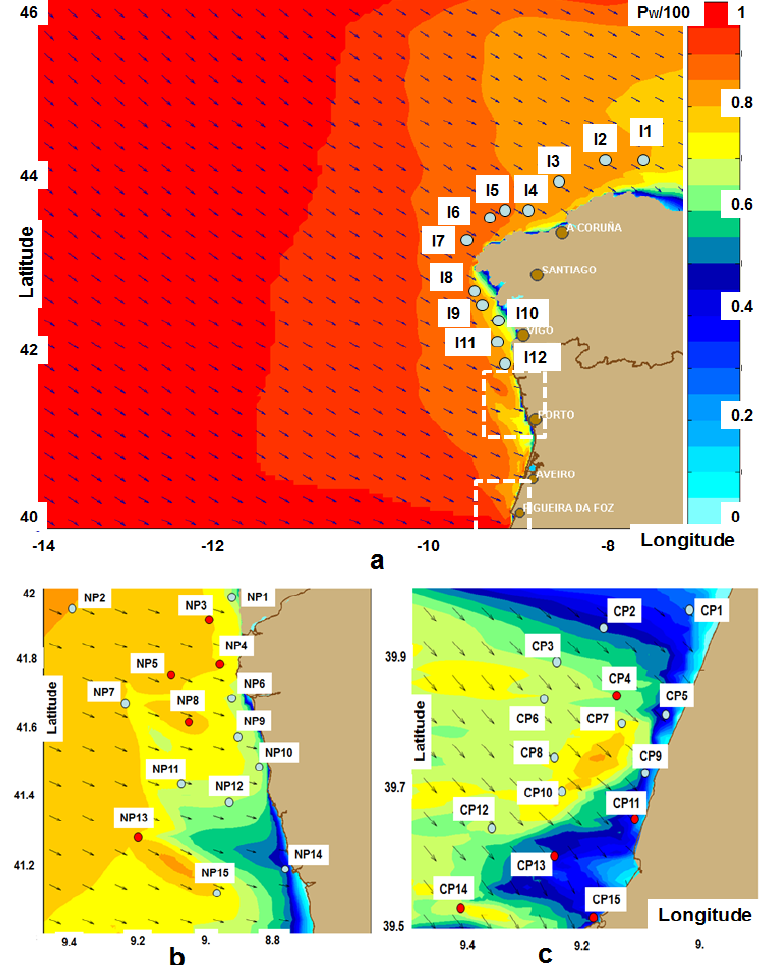
Figure 2. Distribution of the mean relative wave power and the positions of the reference points in the northwest Iberian and Portuguese coastal environments ( a ) the northwestern Iberian nearshore (denoted as the Spanish nearshore), SWAN simulation corresponding to the time frame 2010/01/16/h18 reflecting high non storm energy conditions, the positions of 12 reference points are also indicated (I-points), the computational domains considered in the Portuguese nearshore are also indicated. The extents of the geographical spaces corresponding to the subsequent northern and central computational domains are also illustrated. ( b ) and ( c ) the northern and central domains defined in the Portuguese nearshore, SWAN simulations corresponding to the time frame 2010/04/22/h18 reflecting average wave energy conditions, the positions of 15 reference points are defined in each case (NP and CP-points,